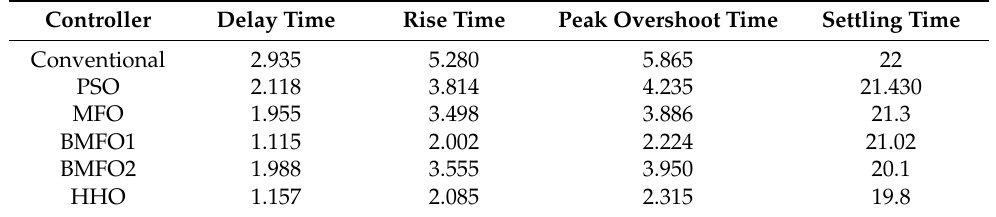
Table 6. Graph analysis of deviation in tie-line error with various controller under unilateral contract. Controller